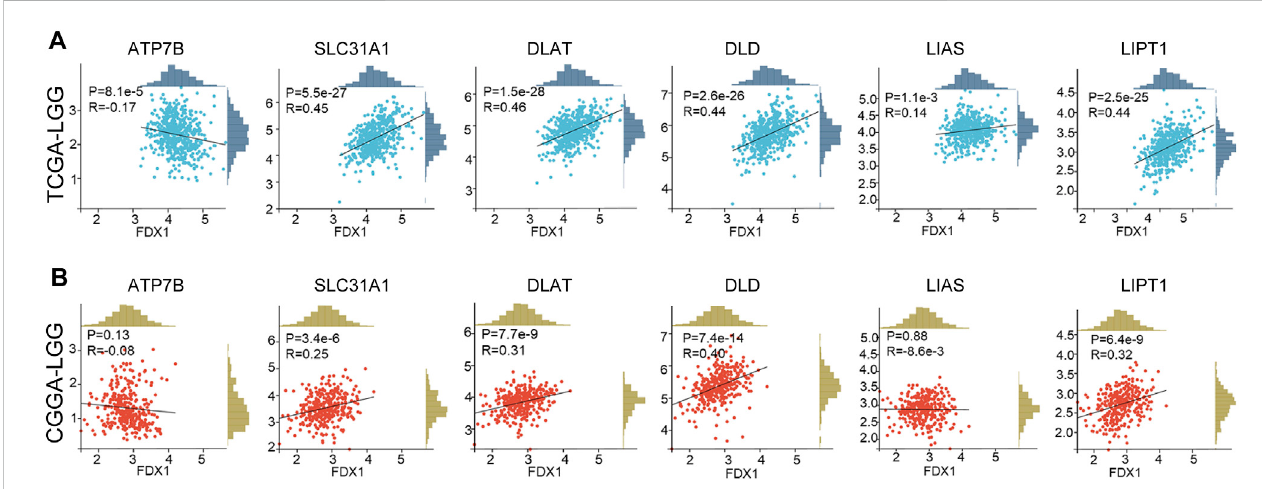
FIGURE 11 Correlation between FDX1 expression and cuproptosis-related genes. (A) The relationship between FDX1 expression and cuproptosis-related genes in TCGA-LGGdataset. (B) TherelationshipbetweenFDX1expressionandcuproptosis-relatedgenesinCGGA-LGGdataset.[Cuproptosis-relatedgenes:ATP7B, SLC31A1, dihydrolipoamide S-acetyltransferase (DLAT), dihydrolipoamide dehydrogenase (DLD), lipoyl synthase (LIAS), and lipolytransferase 1(LIPT1). Correlation analysis: Pearson coef fi cient, p < 0.05 was considered signi fi